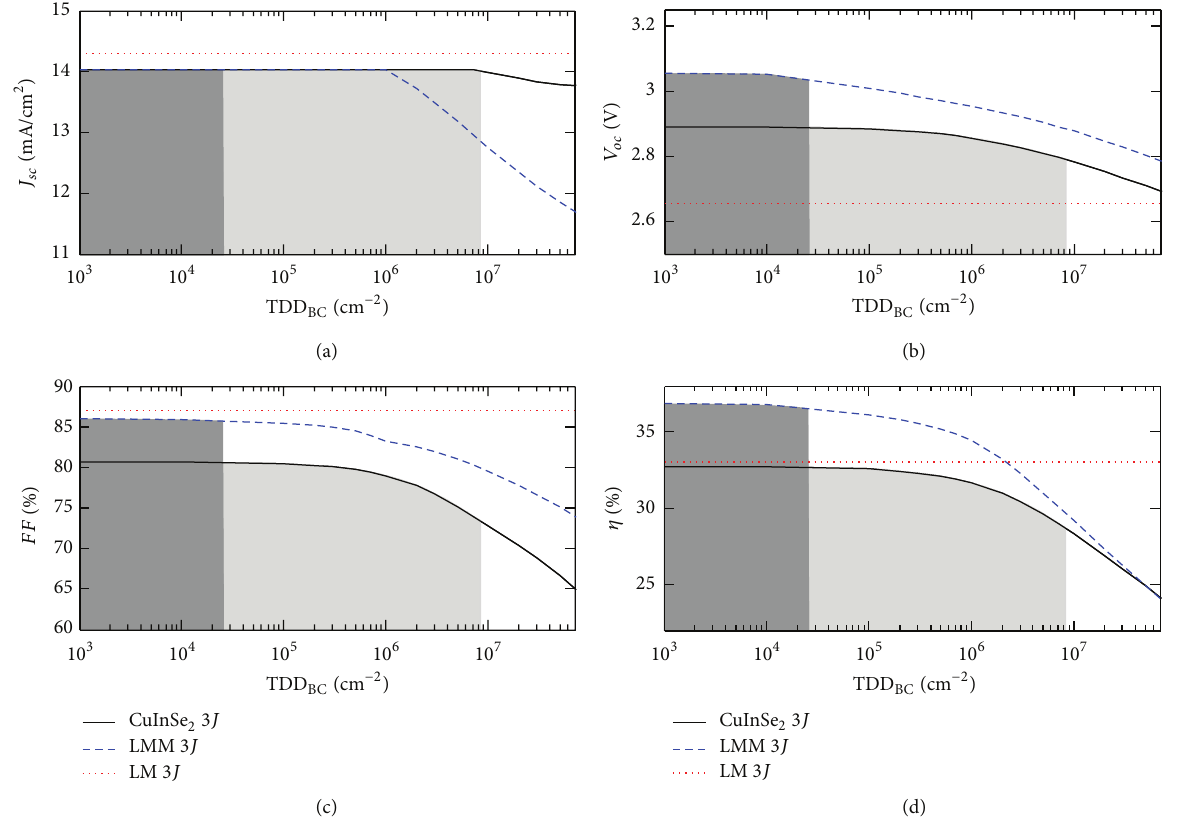
Figure 7: Simulated (a) 𝐽 , (b) 𝑉 , (c) FF and (d) 𝜂 as a function of threading dislocation densities TDD bot in the active region of the bottom sc oc = 10 6 c −2 m and surface recombination velocities of 1 × 10 3 cm/s at the GaInAs/CuInSe subcell with TDD CGB interface, illuminated by the AM1.5D spectrum (1000 W/m 2 ) at 300 K. The light and dark gray regions indicate the threshold level of TDD bot for the CuInSe 2 and LMM devices, respectively, for a reduction in minority carrier lifetime by a factor of